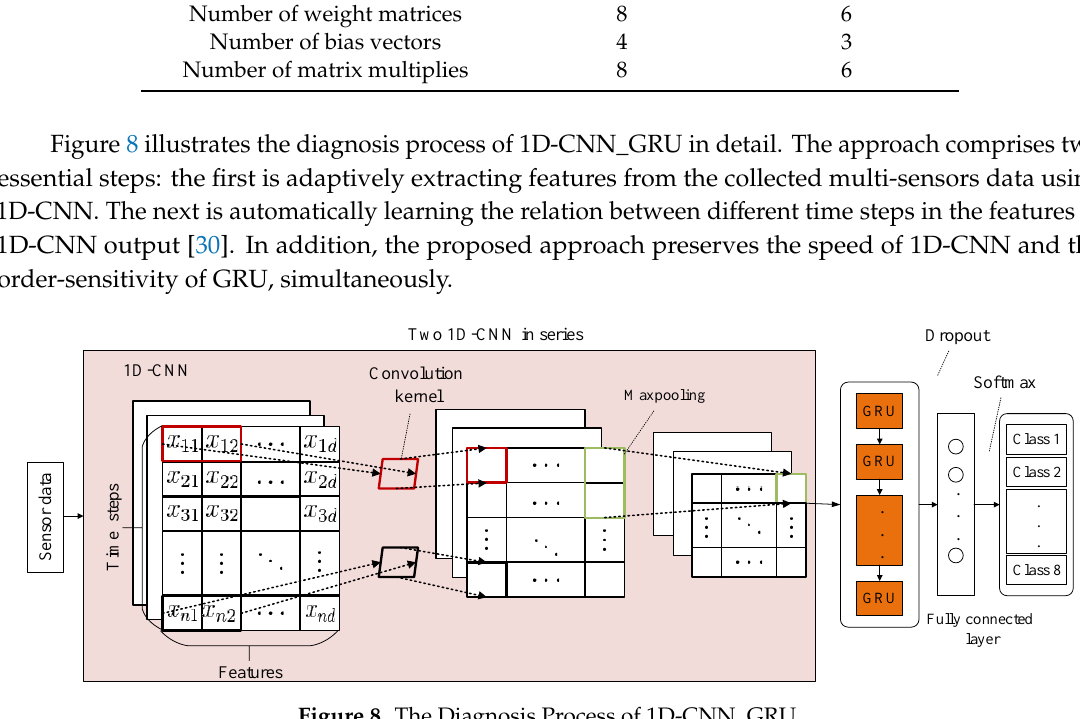
Figure 8. The Diagnosis Process of 1D-CNN_GRU.